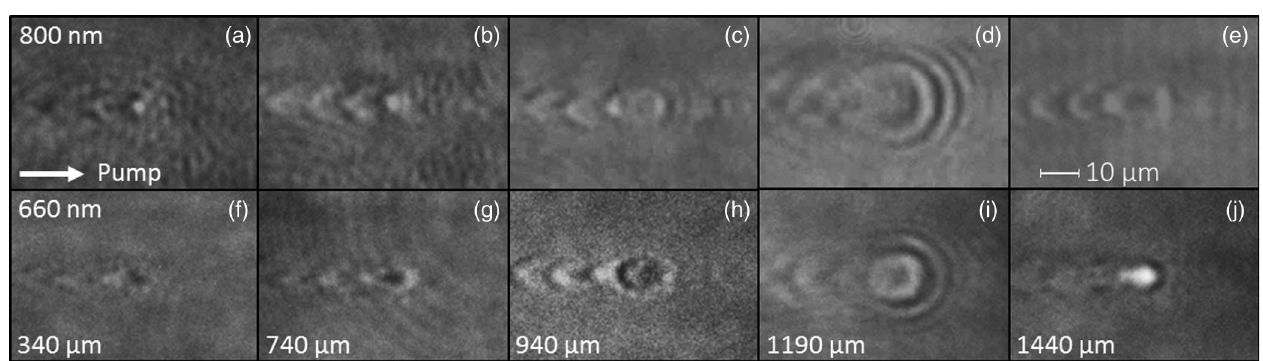
FIG. 2. From left to right, each column shows a single position along the pump ’ s propagation. The pump ’ s approximate position relative to the gas-cell entrance ’ s inside edge for each image pair is given in the lower left corners of the bottom row. The H-pol probe ’ s spectrum was filtered by 40 nm FWHM bandpass filters centered at 800 nm (a) – (e) and 660 nm (f) –